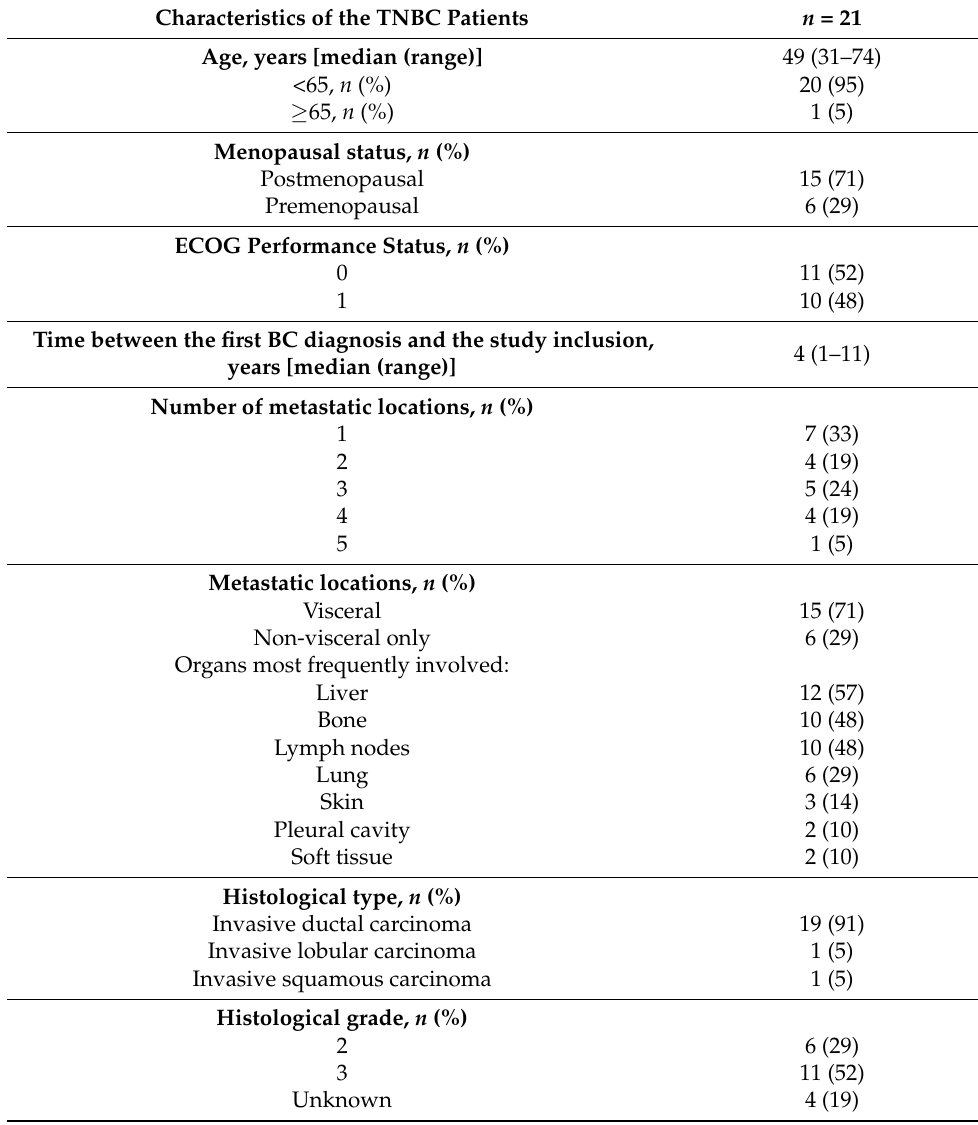
Table 1. Patients’ and disease characteristics of the triple-negative breast cancer subpopulation. Characteristics of the TNBC Patients n =